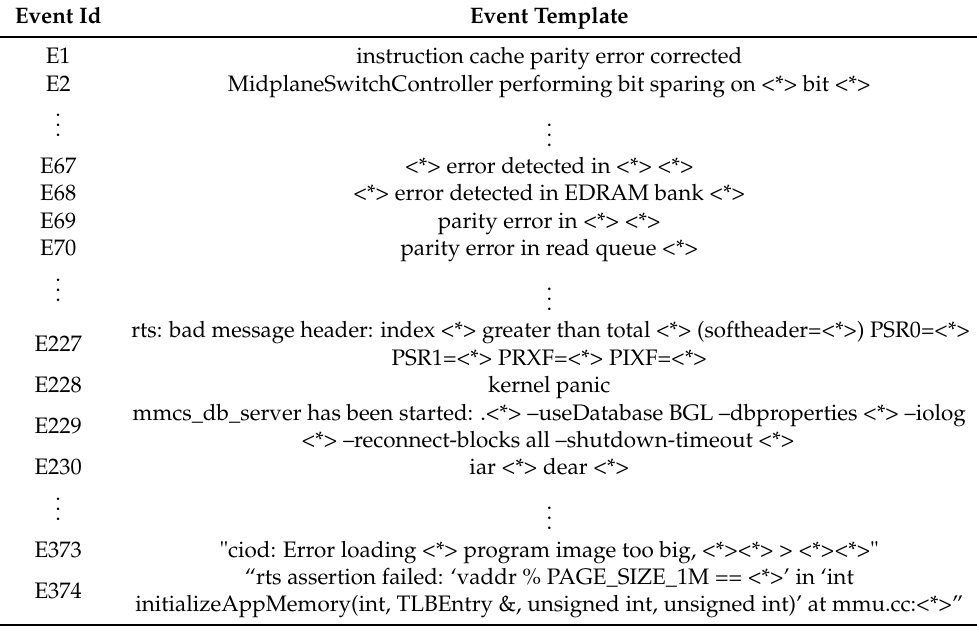
Table 1. Log templates obtained by parsing BGL logs through the